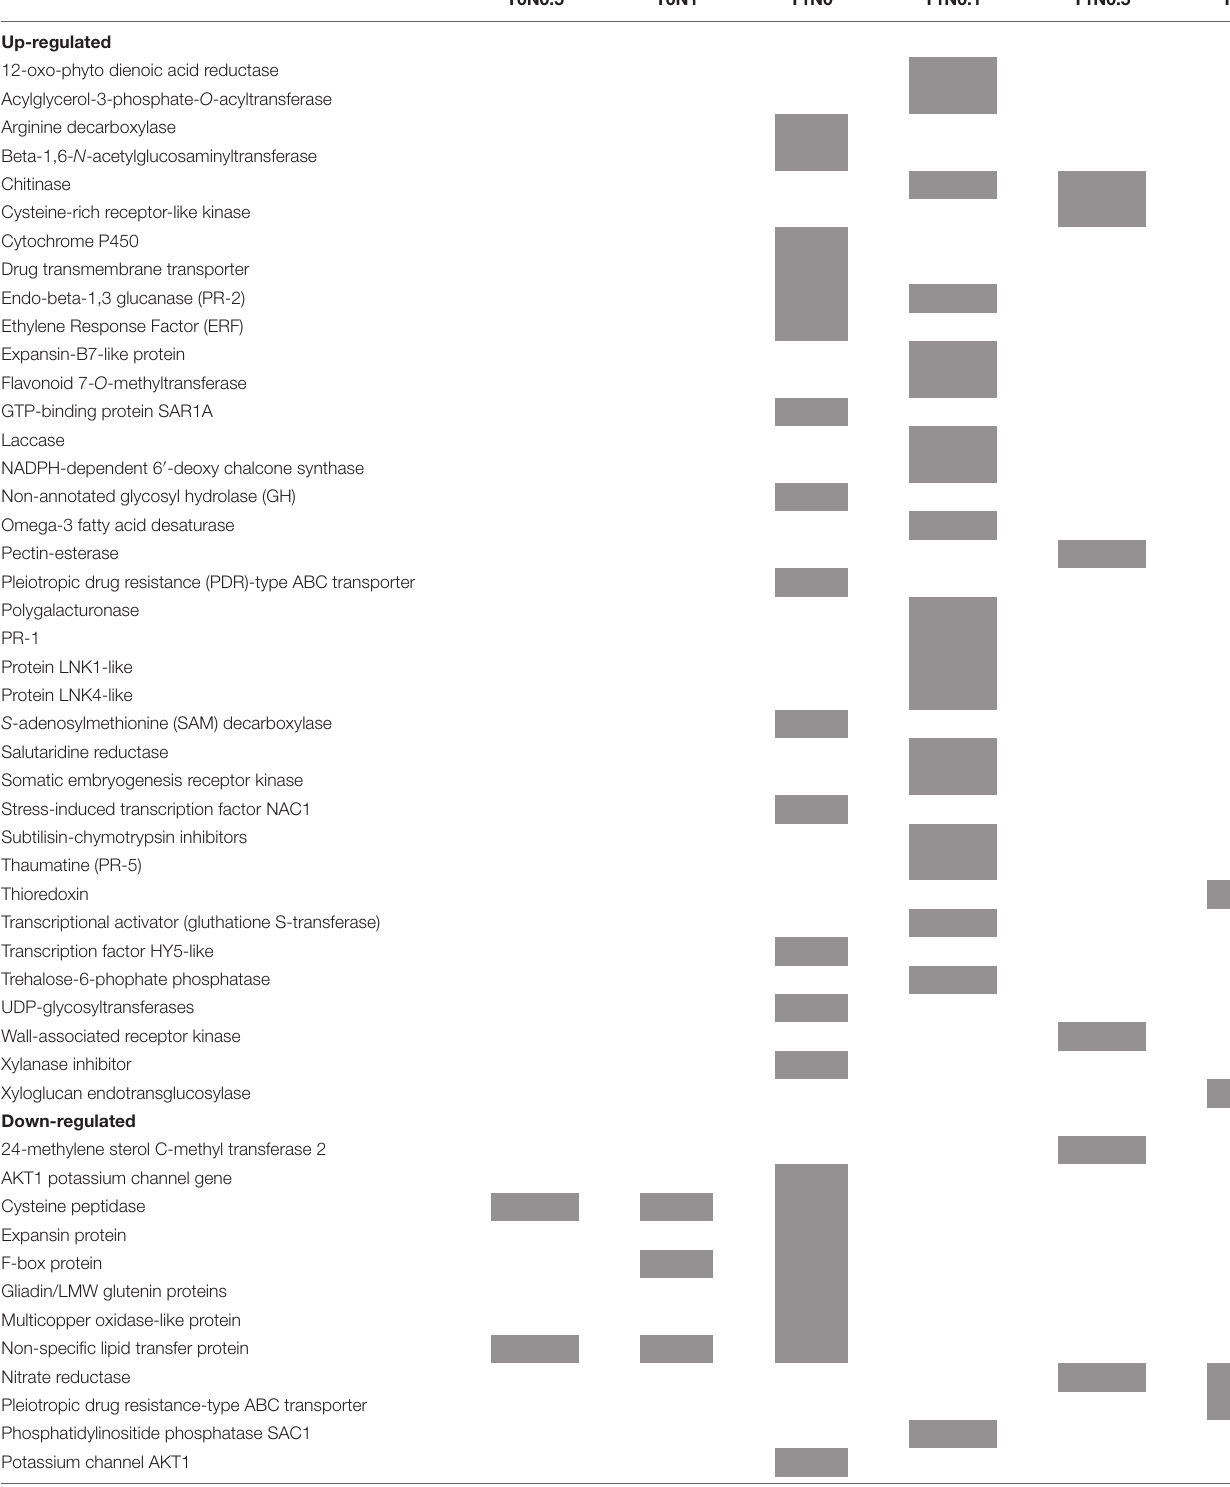
TABLE 1 | Short list of annotated hits for wheat genes that alter their expression in response to Trichoderma and/or calcium nitrate selected due to their putative role in plant defense or